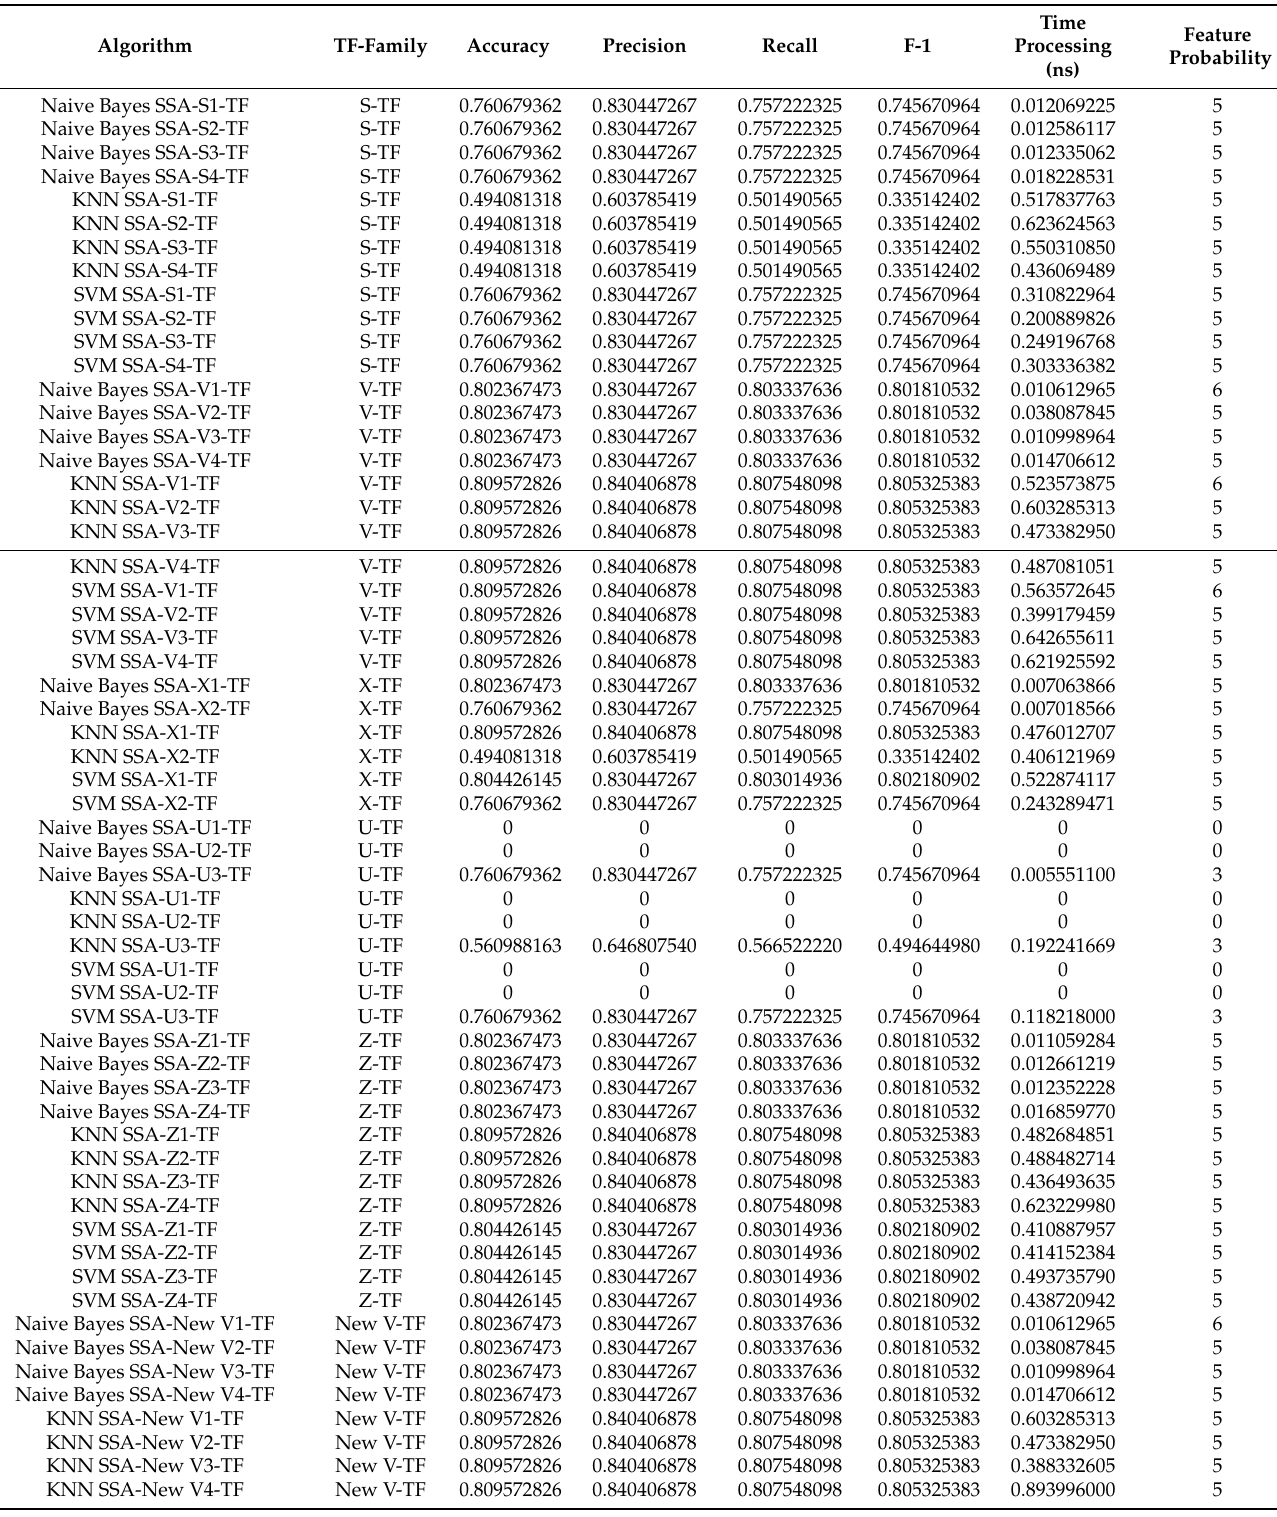
Table A1. Comparison accuracy, precision, recall, F-1, time processing and feature probability of various SSA-TF versions and other conventional optimizers with classifier machine